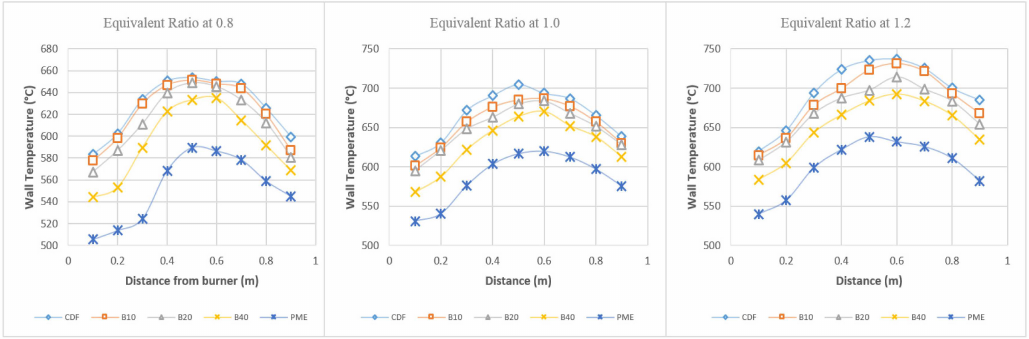
Figure 4. Wall temperature profiles for the 1.25 nozzle.